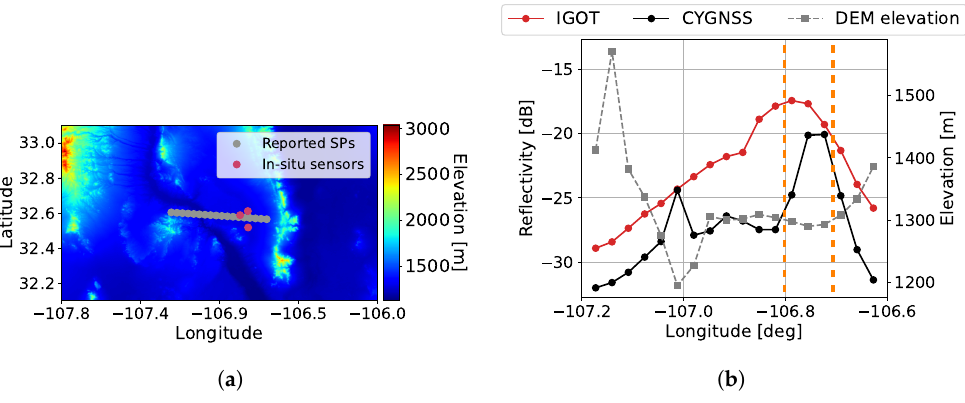
Figure 9. JER track 2: ( a ) Track elevation map; ( b ) Peak reflectivity. The SoilSCAPE sites are between the orange vertical